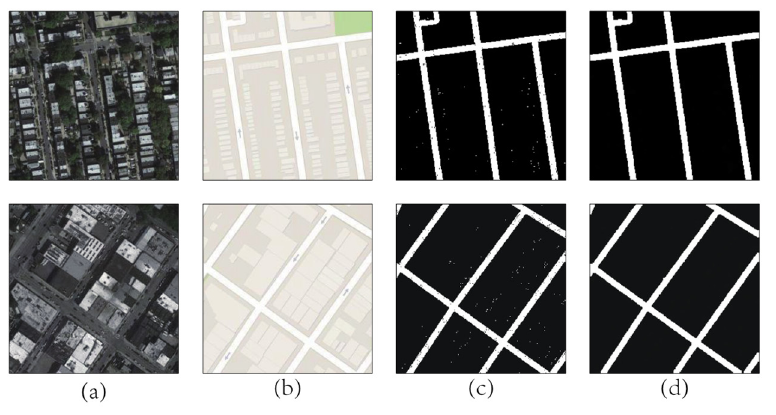
Figure 6. Example of the model’s training dataset: ( a ) remote sensing image, ( b ) mapping image, ( c ) binary image with the salt-and-pepper noise, and ( d ) extracted result.